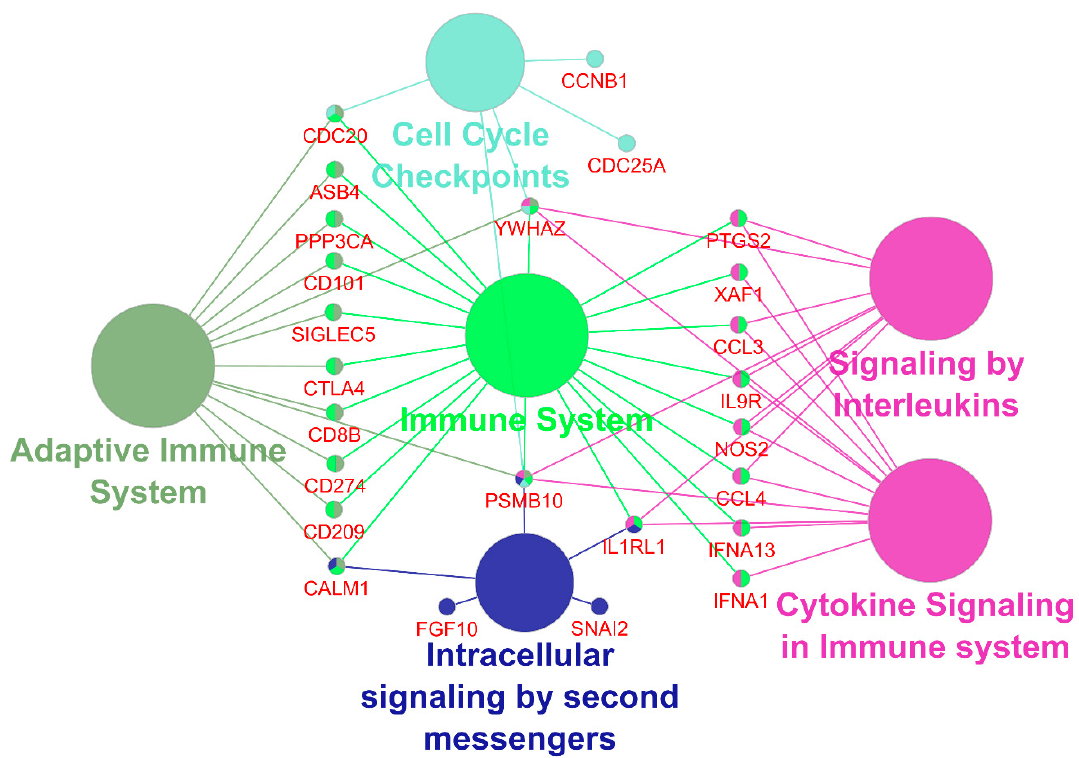
Figure 4. Top Genes from all the clusters that are associated with five representative terms and pathways using REACTOME_pathways ontology database. A total of 33 of top 40 prominently deregulated genes are statistically overrepresented in a functional network of ‘Intracellular signaling by second messengers’, ‘Signaling by Interleukins’ and ‘Cytokine Signaling in Immune System’, ‘Cell Cycle Checkpoints’, ‘Adaptive Immune System’ and ‘Immune System’ (Term p -value and group p -value corrected by Bonferroni step down below 0.01, Final Kappa Score groups = 4, redundant groups merged with >50.0% overlap.